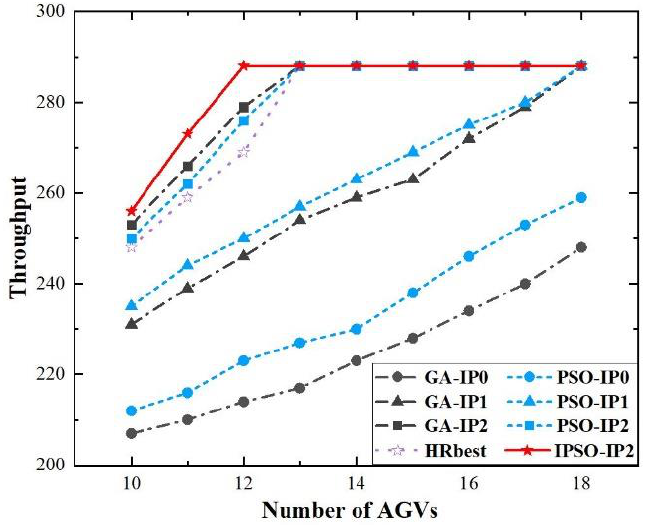
Figure 8. The 48-h simulations under different number of AGVs and different methods. Figure 8. The 48‑h simulations under different number of AGVs and different